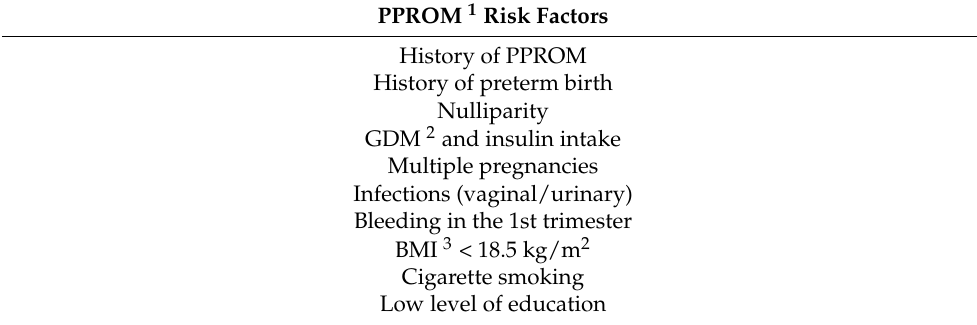
Table 1. Summary of postulated premature rupture of membranes risk